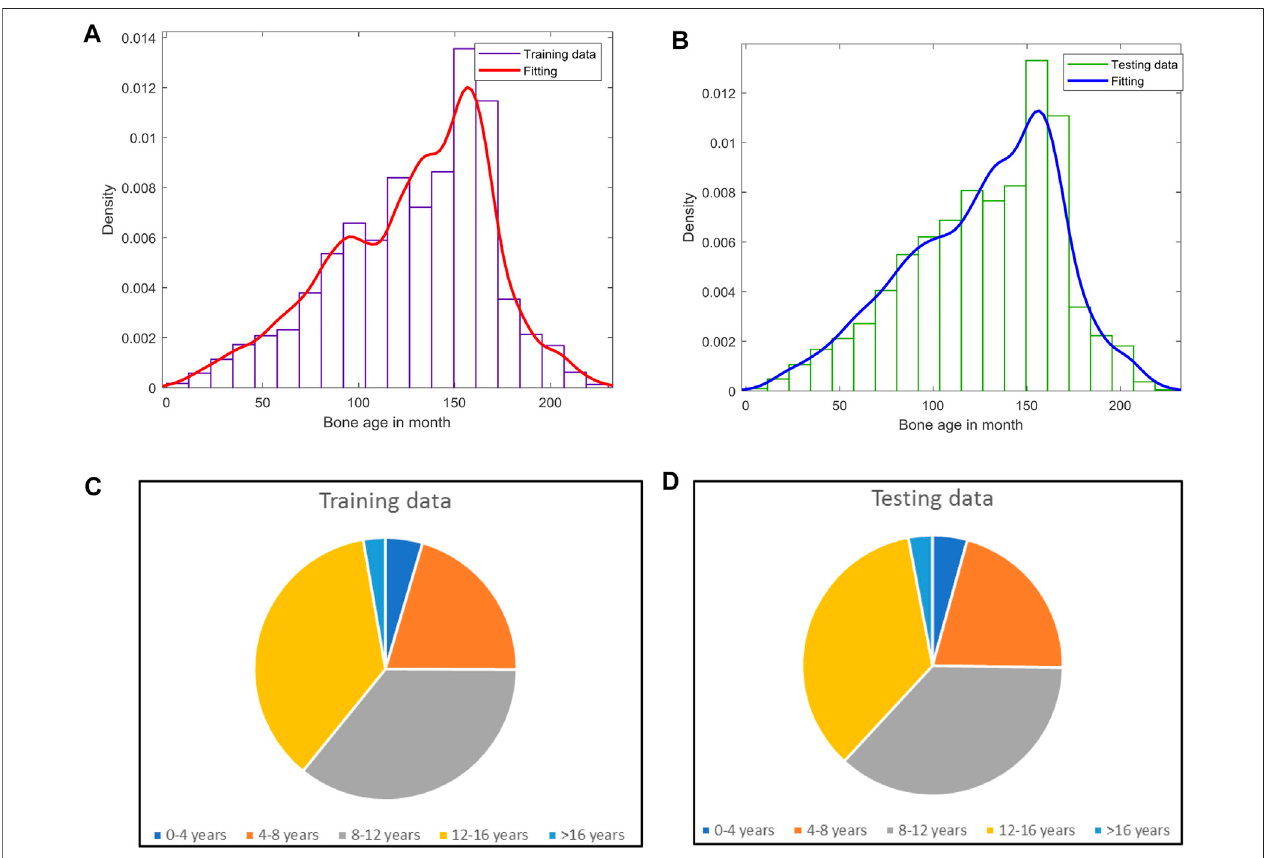
FIGURE 4 | Distribution of bone ages. The distribution of ages based on training data (A) and testing data (B) . (C) and (D) plot the ratio of different age phases in training data and testing data, respectively.